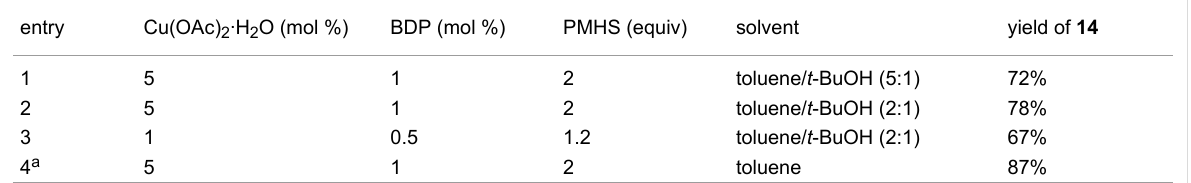
Table 2: Optimization of Cu–H-catalysed reduction of 16 .